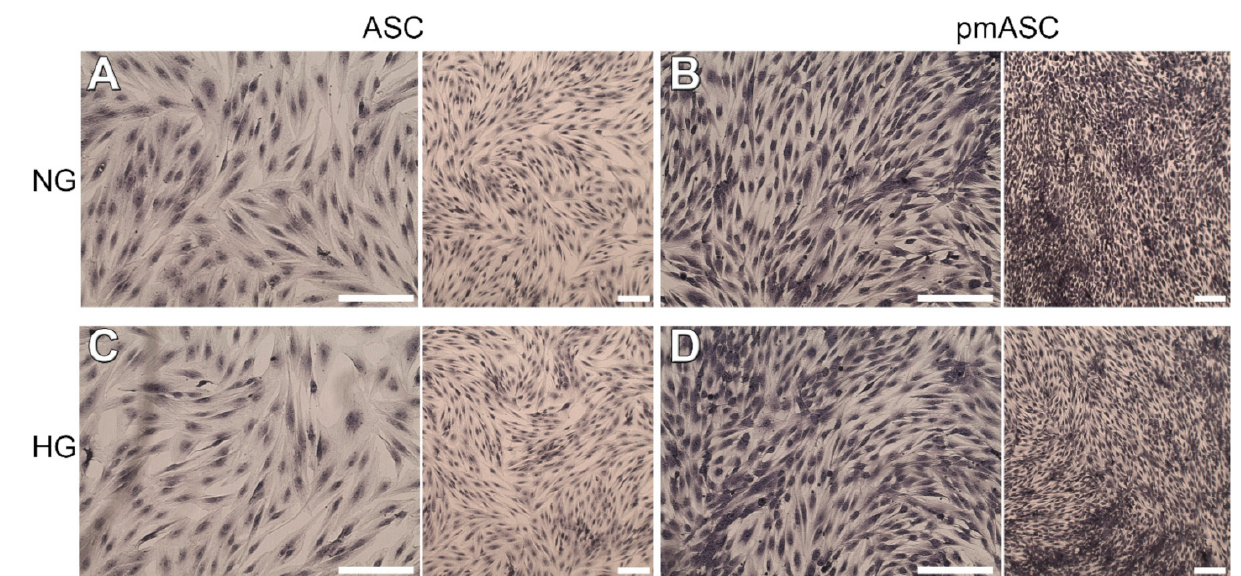
Figure 1. Representative photomicrographs of human adipose mesenchymal stem cells cultured in basal medium (ASC) or in pericyte medium (pmASC), stained by crystal violet during cellular proliferation assays. After three days of growth in their respective medium, glucose was added in some samples (High Glucose, 25 mM, HG), whereas other samples were kept in normal glucose (NG) condition. Pictures were taken after 72 h from glucose addition and compared to NG samples. A : ASC NG; B : pmASC NG; C : ASC HG; D : pmASC HG. In each image, two magnification levels are shown (10 × and 4 × , respectively). Scale bar: 100 µ